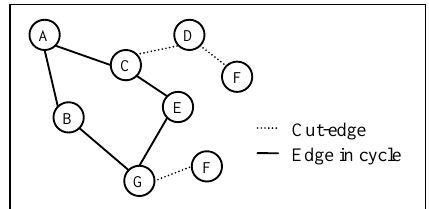
Figure 3. Cut-edges in an undirected